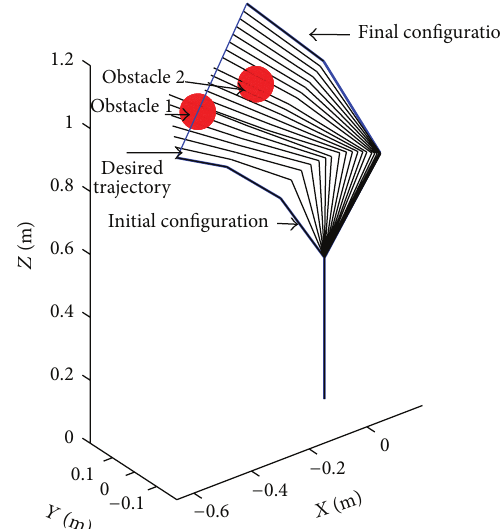
Figure 7: Traces for obstacle avoidance using the traditional approach.